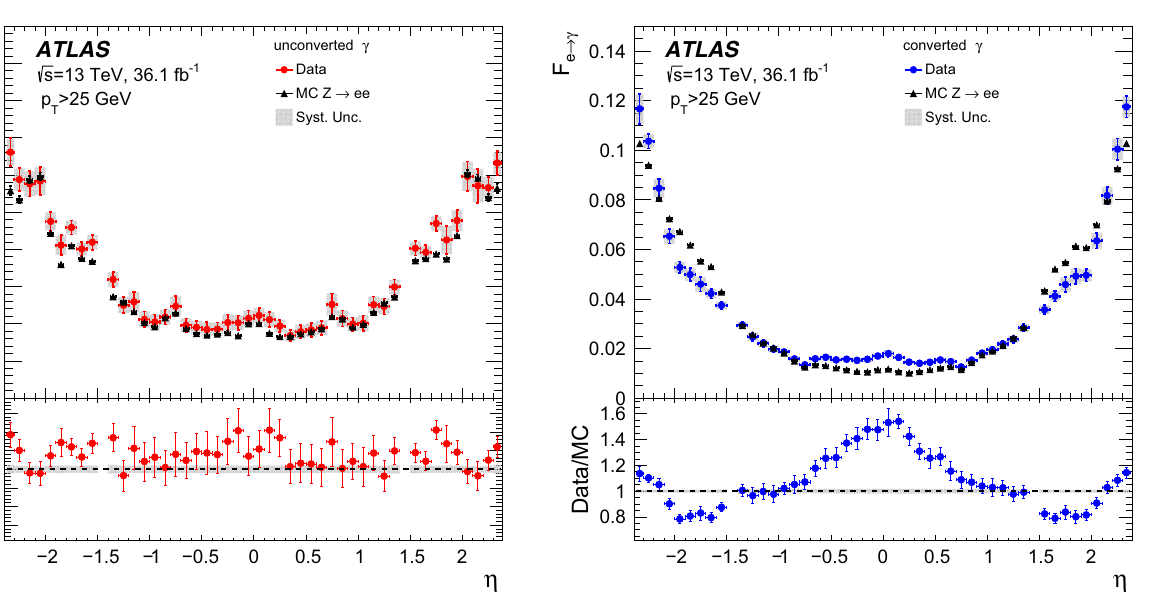
tainties, and gray shaded areas correspond to systematic uncertainties. The bottom plot shows the ratio of the two measurements. The error bars correspond to the scaled data uncertainty and the gray dashed area corresponds to the relative MC uncertainty